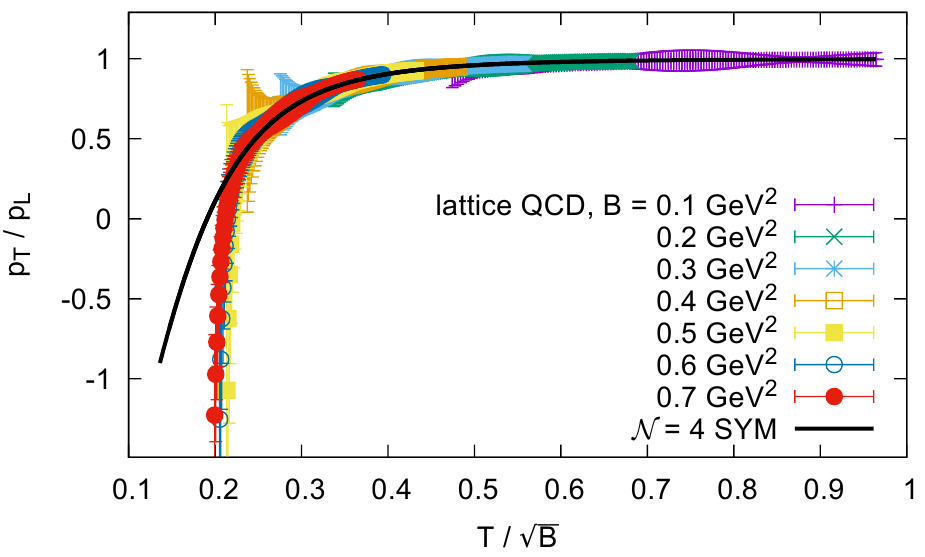
p B at optimal universality |